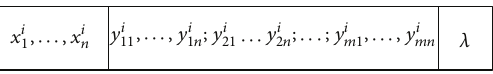
Figure 3: Structure of one